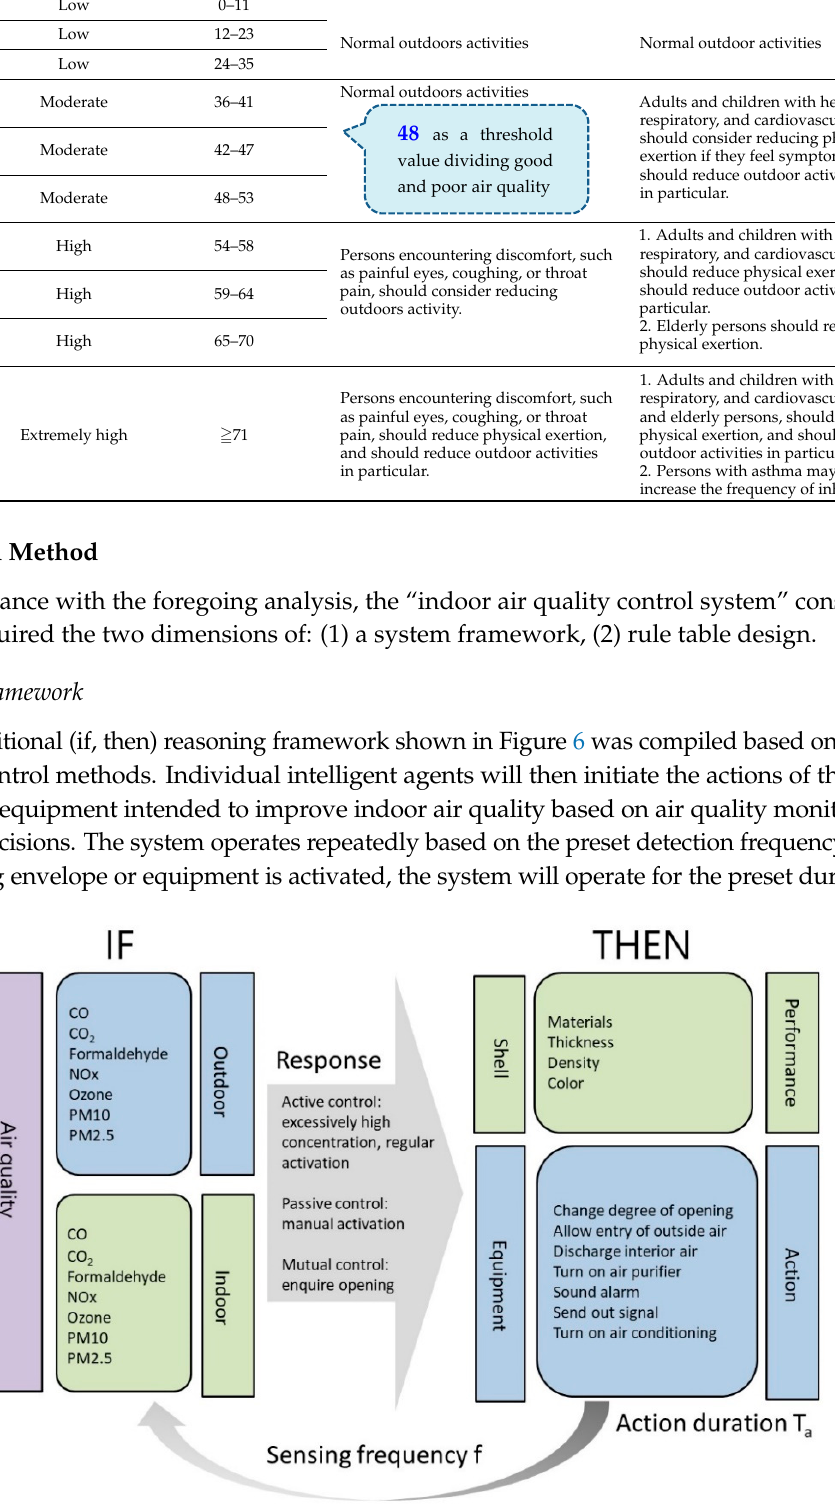
Figure 6. Factors influencing air quality and control